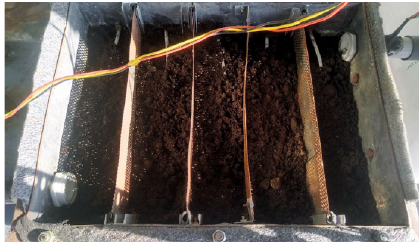
Figure 4: Photographic view of the cooling chamber loaded with vermicompost.